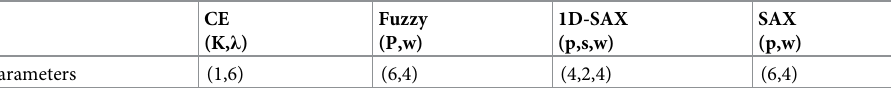
Table 3. Parameters used for the AD methods.